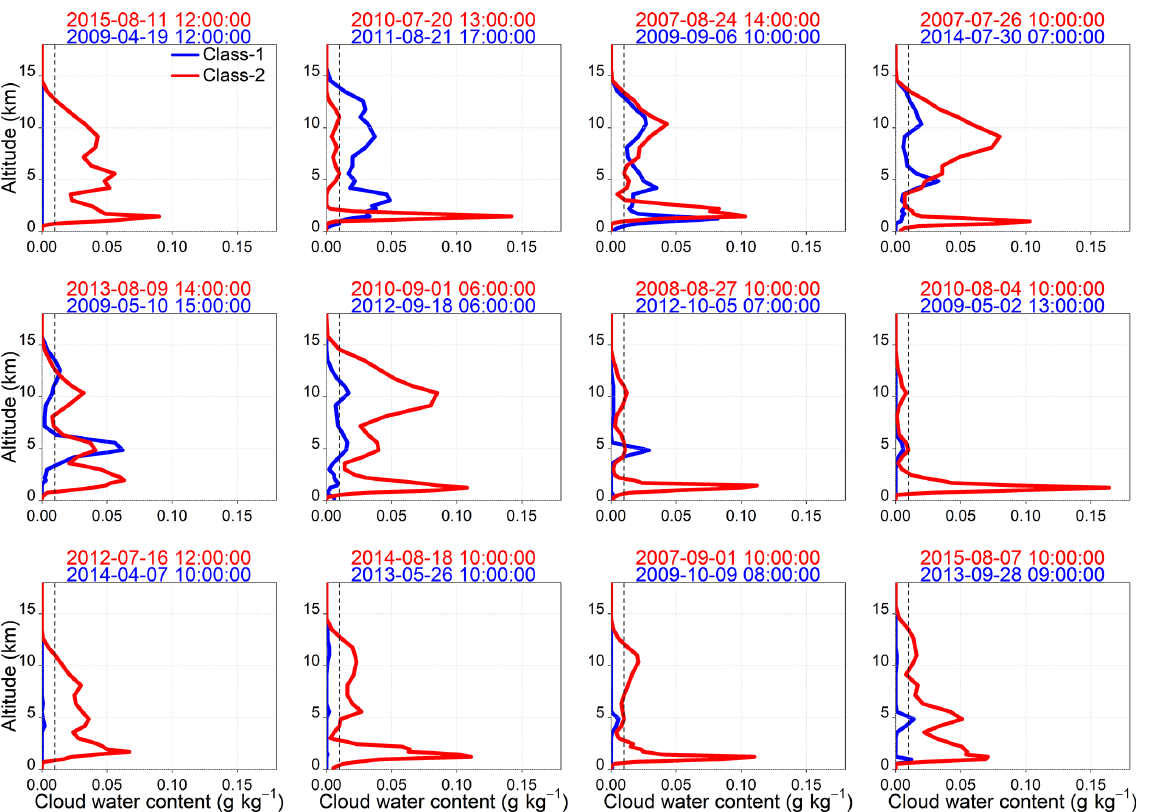
Figure A1. Vertical profiles of cloud hydrometeor content (liquid and ice water) during the occurrence of LLC Class-1 and Class-2 events in the Sahel region. These events are randomly chosen. The timestamps at the top of each plot are the times for those LLC events. The black dashed vertical line shows the threshold for deep convective clouds as defined by Storer and Van den Heever